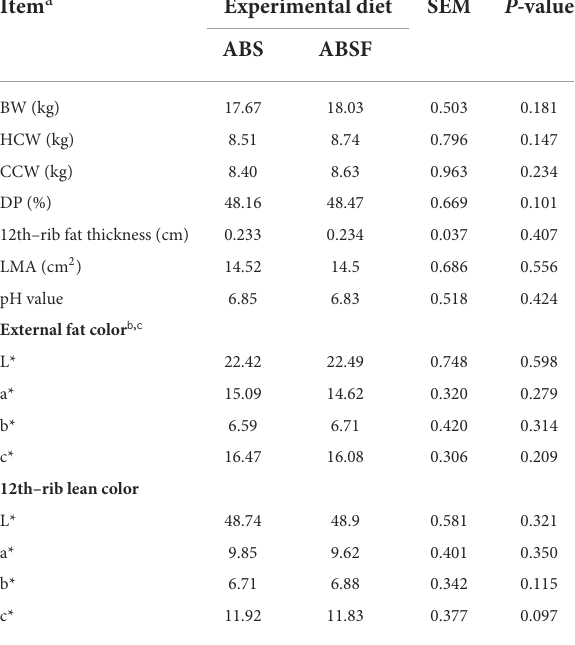
TABLE 5 Carcass characteristics of goats fed a total mixed ration supplemented with anthocyanin-rich black cane silage (ABS) or anthocyanin-rich black cane silage treated with ferrous sulfate heptahydrate (ABSF).